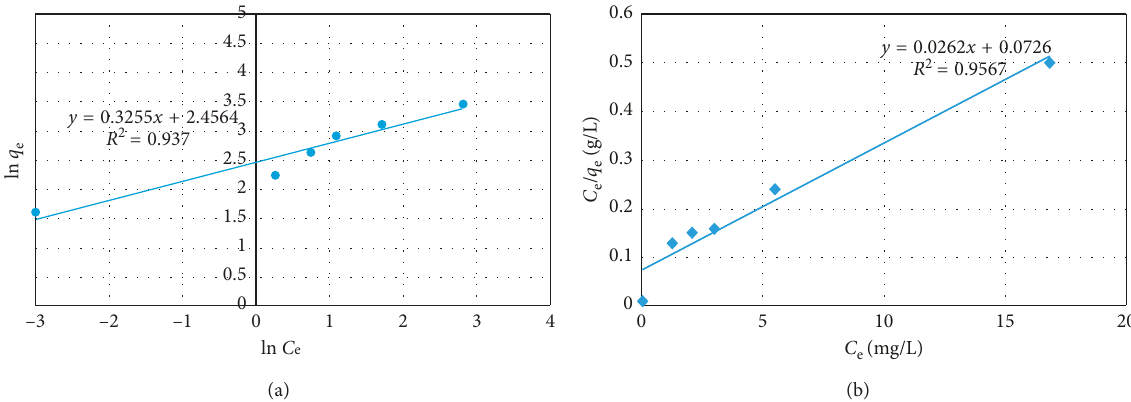
y = 0.3255 x + 2.4564 R 2 = 0.937